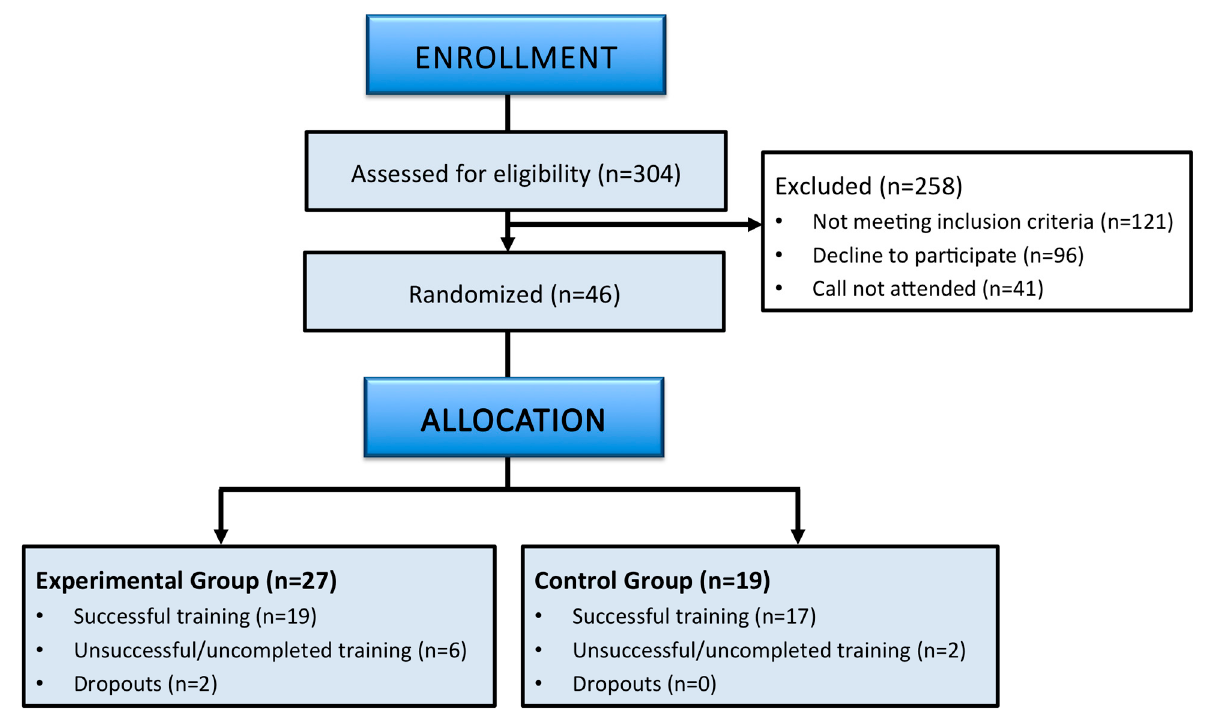
Figure 1. Flow diagram of the study recruitment with the sample according to CONSORT reporting guidelines (Schulz et al. 2010).